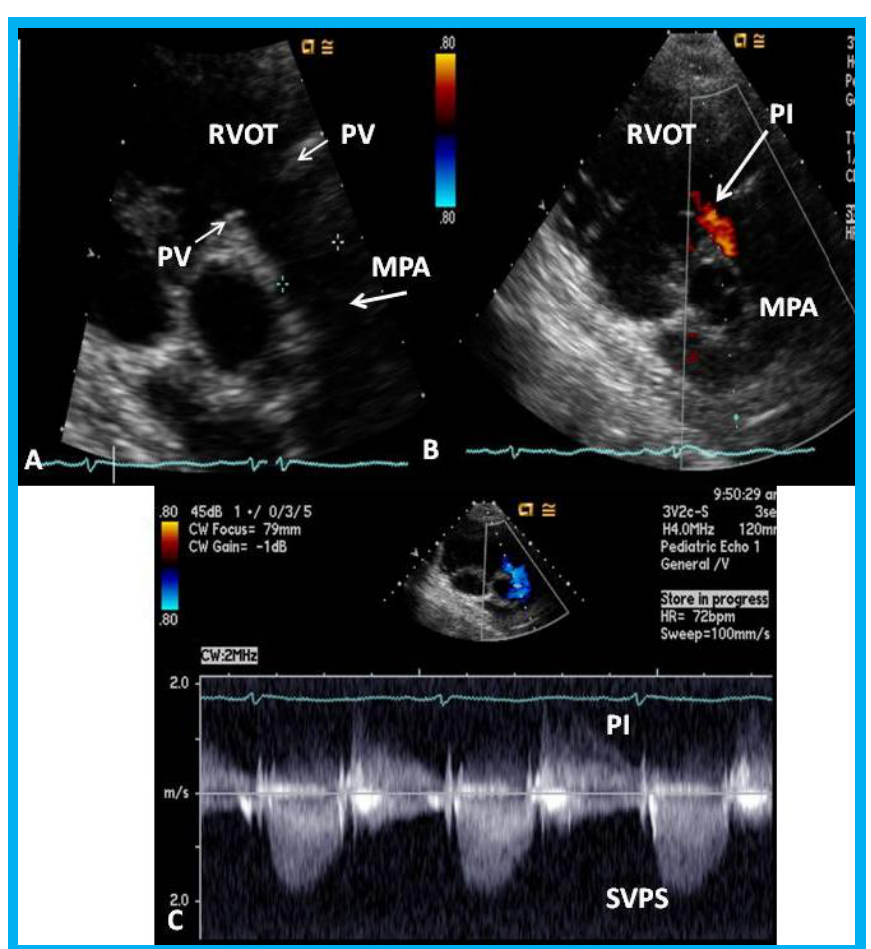
Figure 22. Echo-Doppler studies performed five months after removal of the Nuss bar: ( A ) Selected video frame from a parasternal short axis view demonstrating no echo dense structures in the right ventricular outflow tract (RVOT) and main pulmonary artery (MPA) that was seen prior to removal of the Nuss bar (Figure 20A). Pulmonary valve (PV) leaflets (arrows) are shown. ( B ) Color-Doppler mapping of the same structures as in panel A shows mild pulmonary insufficiency (PI) (arrow). ( C ) Continuous wave Doppler sampling demonstrating low Doppler flow velocity across the MPA with a calculated peak instantaneous gradient of 15 mmHg, indicating minimal supravalvular pulmonary stenosis (SVPS) and mild pulmonary insufficiency (PI). Reproduced from Mazur L., et al. [31].